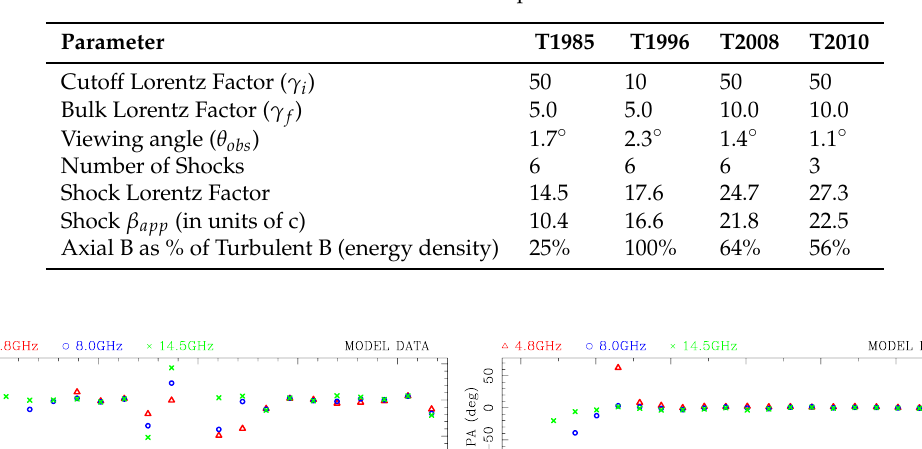
Table 1. Derived flow parameters.